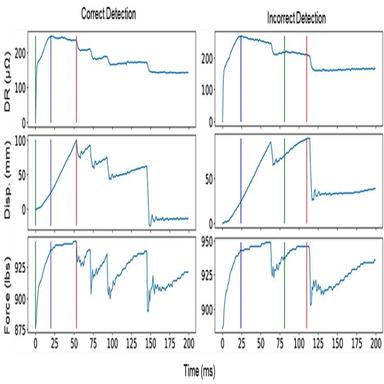
Phase transition detection of expulsed weld with no IDL.